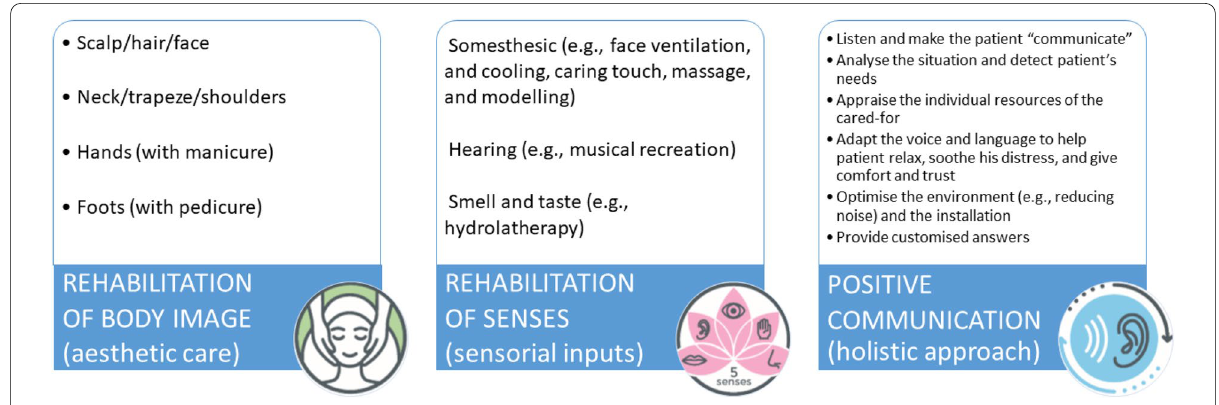
Fig. 1 Corporeal rehabilitation